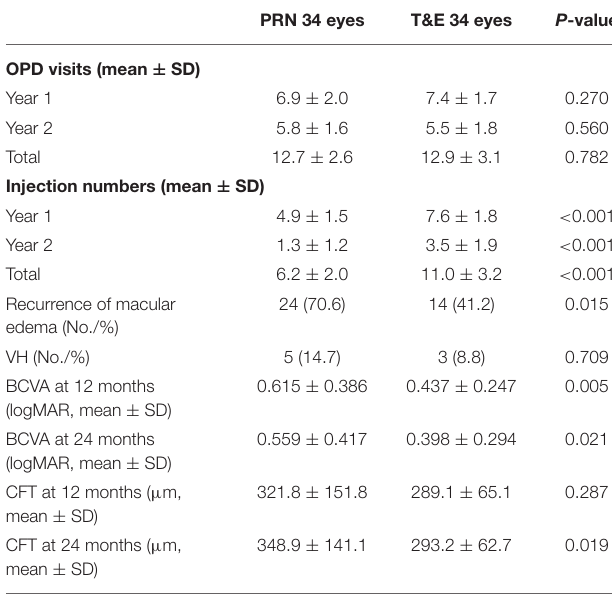
TABLE 2 | Treatment outcomes of patients with diabetic macular edema who underwent anti-vascular endothelial growth factor therapy using ranibizumab with pro re nata or treat-and-extend